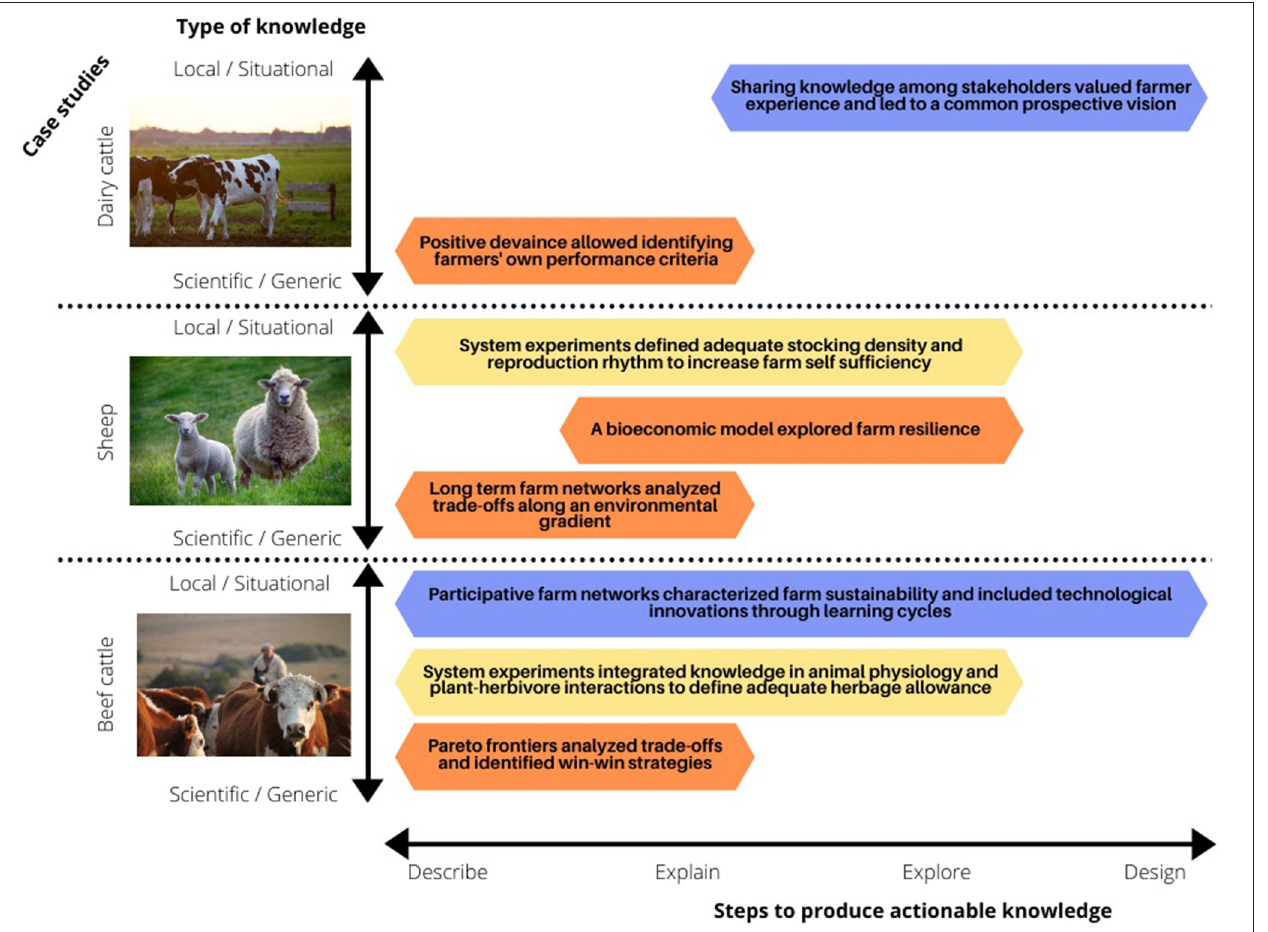
FIGURE 5 | In each production (dairy cattle, sheep, beef cattle), the different case studies from this article were reported along two axes according to the steps used to produce actionable knowledge (describe, explain, explore, design) on the X-axis and the type of knowledge that is being used (scientific—generic vs. local—situational) on the Y-axis. Box colors indicate the research approach: brown for trade-off analysis in farm network data, yellow for long-term system experiments, and blue for co-innovation.